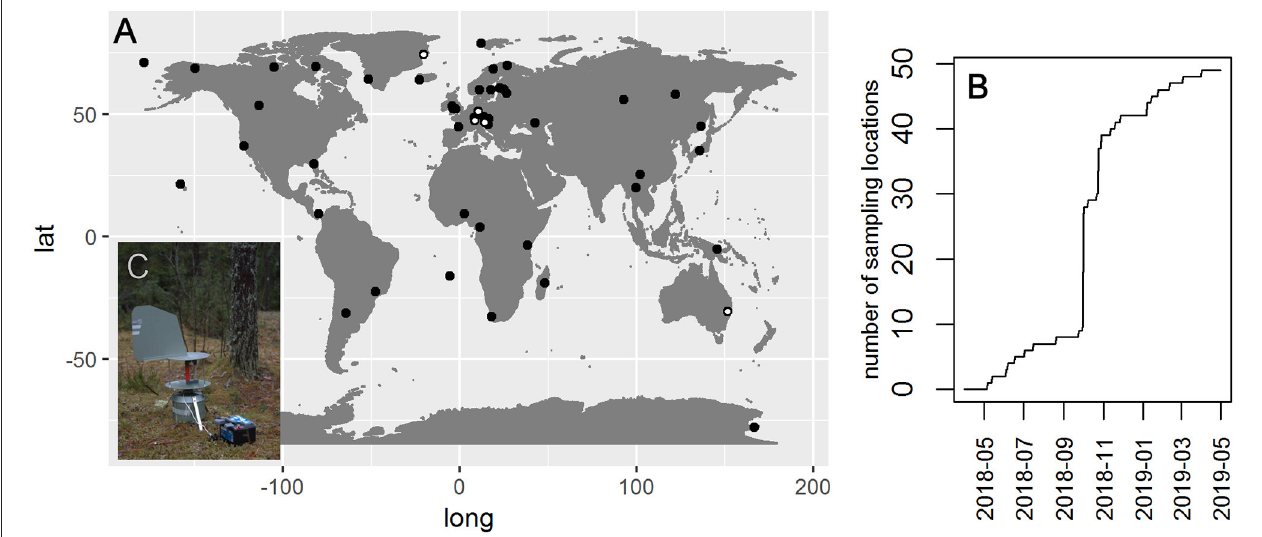
FIGURE 1 | GSSP sampling locations (A) and the increase in the number of sampling locations over time (B) . The five locations from which the pilot data analyzed in this paper originate are indicated by white dots. (C) Shows the cyclone sampler connected to a car